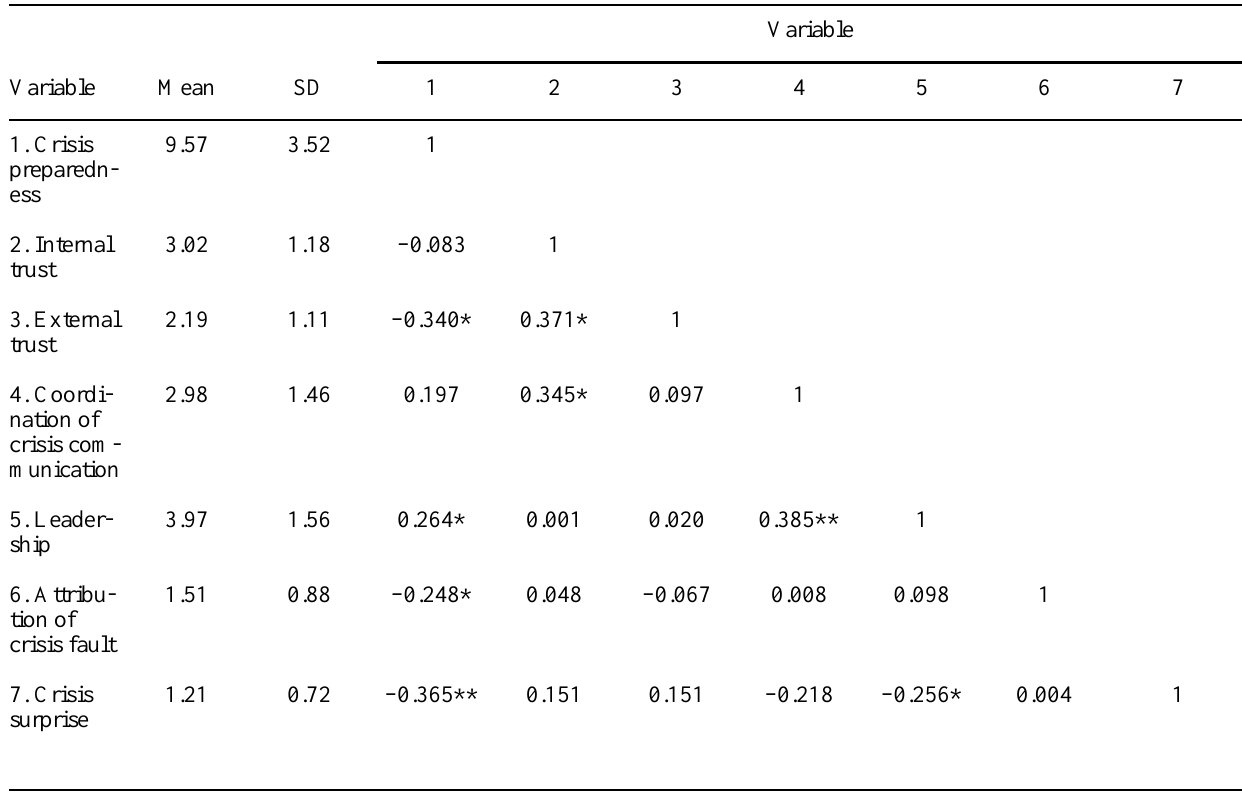
Table 3. Zero-order correlations of the variables, with means and standard